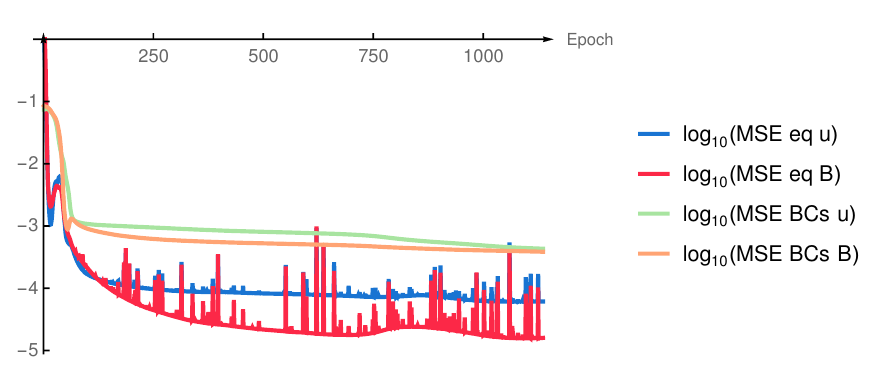
= 0. In panel 9c 1